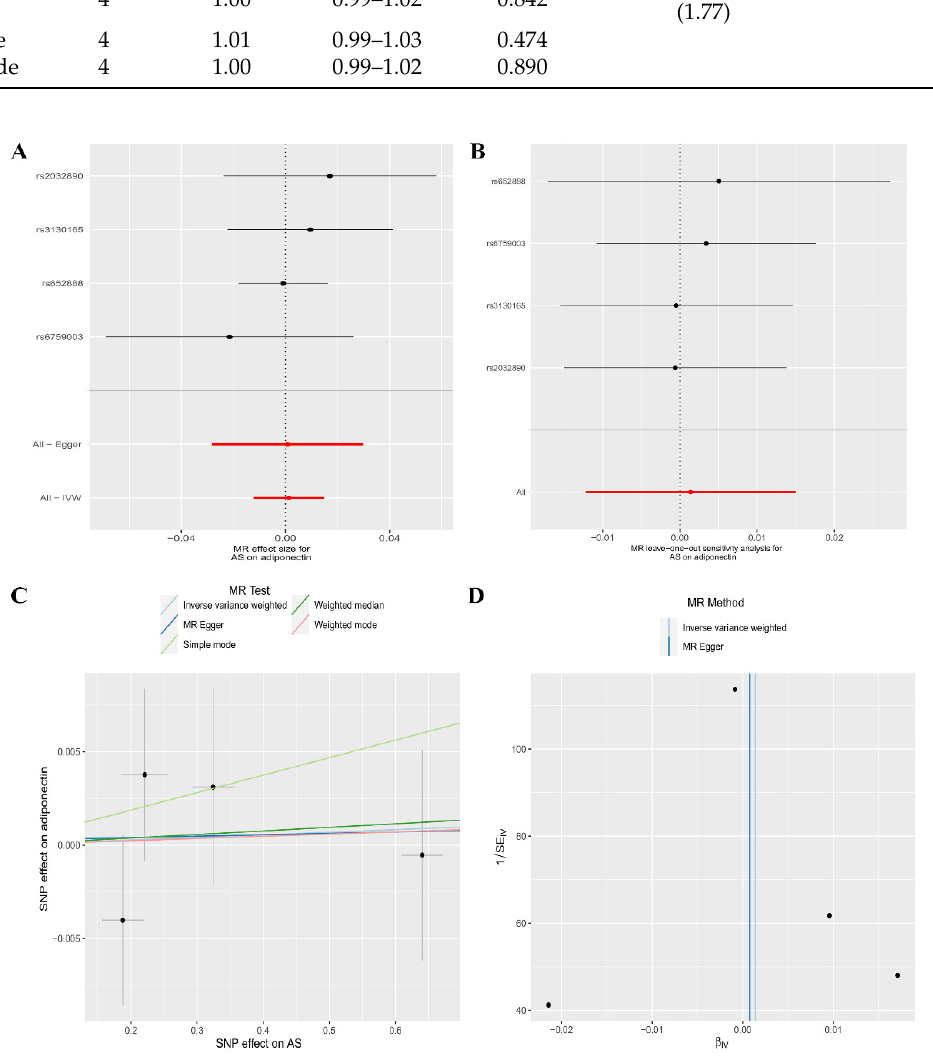
Figure 3. The association between the risk of ankylosing spondylitis and circulating adiponectin levels is presented in ( A ) a forest plot, ( B ) a leave-one-out sensitivity analysis, ( C ) a scatter plot, and (D ) a funnel plot.